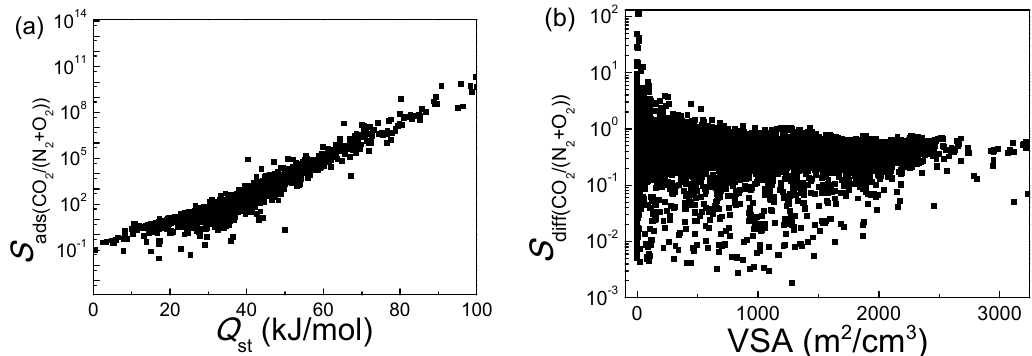
Figure 2. The relationships between ( a ) S ads (CO2/N2+O2) and Q st , ( b ) S diff (CO2/N2+O2) and volumetric surface area (VSA).